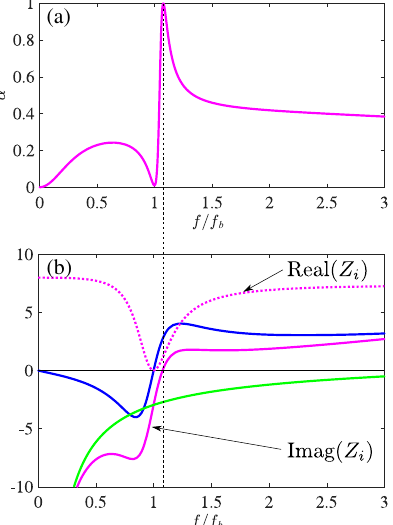
Figure 2. (a) Absorption coef fi cient and (b) impedance com- puted from the mono-articulated model as a function of the frequency normalised by the beam resonance frequency. S b = S i = 0.48, S s = S i = 0.0083, S c = S i = 0.825, k b e b = 0.8133, d ¼ 0 : 01, R ¼ S = S R k e k B = 0.39. The green curve is i s s = 8, b s = 0.0065, b the imaginary part induced by the cavity and the blue curve is the imaginary part induced by the beam and the